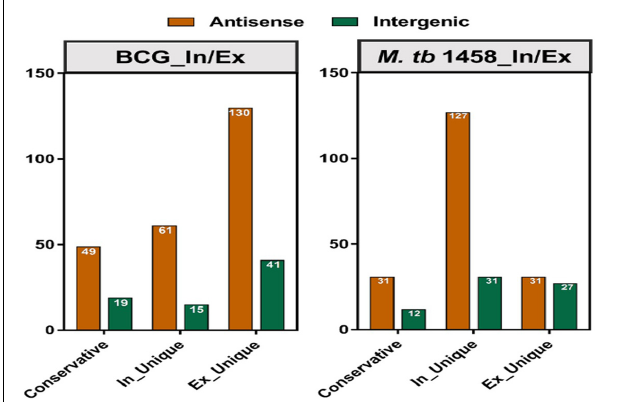
FIGURE 4 | Venn diagram of the overlap after BCG and Mycobacterium tuberculosis 1458 ncRNA sequences are compared. In, intracellular; Ex,